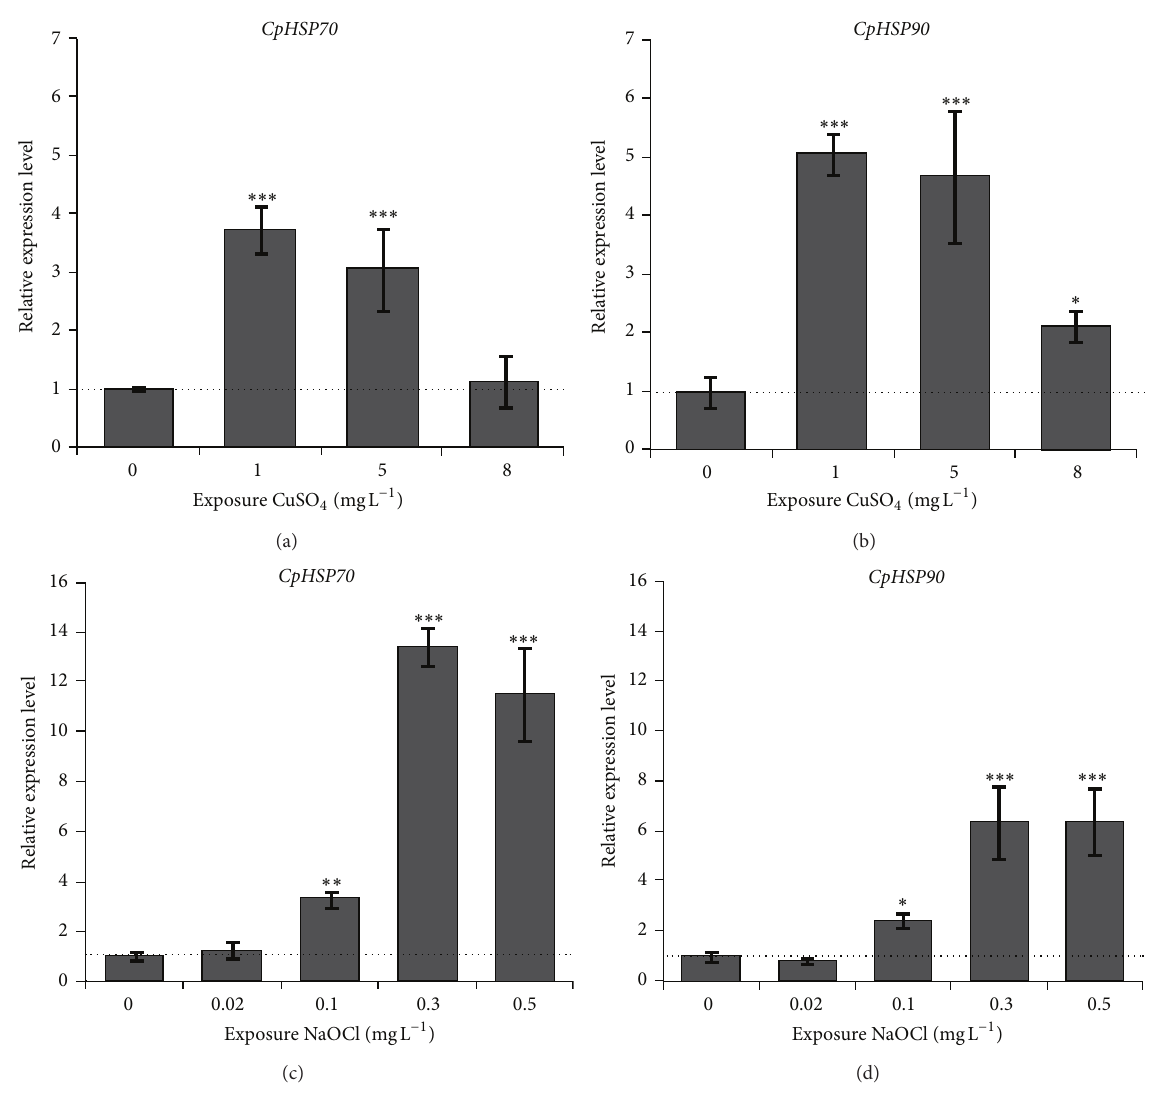
Figure 4: The gene expression profile of CpHSP70 and CpHSP90 after CuSO 4 and NaOCl treatment, respectively. (a, b) Total RNA was extracted from C. polykrikoides at 24h after treatment with 1mg L −1 , 5mg L −1 , and 8 mgL −1 of CuSO 4 , respectively. (c, d) Total RNA was extracted from C. polykrikoides after treatment with 0.02 mgL −1 , 0.10mg L −1 , 0.3 mg/L, and 0.5 mgL −1 NaOCl, respectively. The 18S rRNA gene was used as the internal control to normalize the amount of templates in qRT-PCR. Results are given as the means of triplicate ± SD. The significant differences between the treated group and the control group are highlighted by one-way ANOVA; ∗ 𝑃 < 0.05 , ∗∗ 𝑃 < 0.01 , ∗∗∗ 𝑃 < 0.001